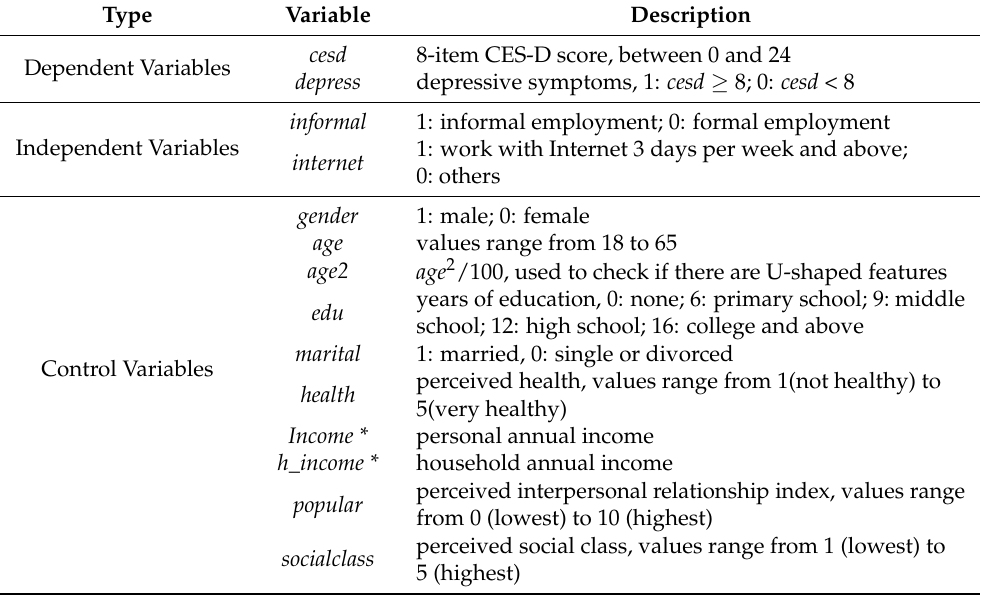
Table 1. Description and value range of variables in the regression